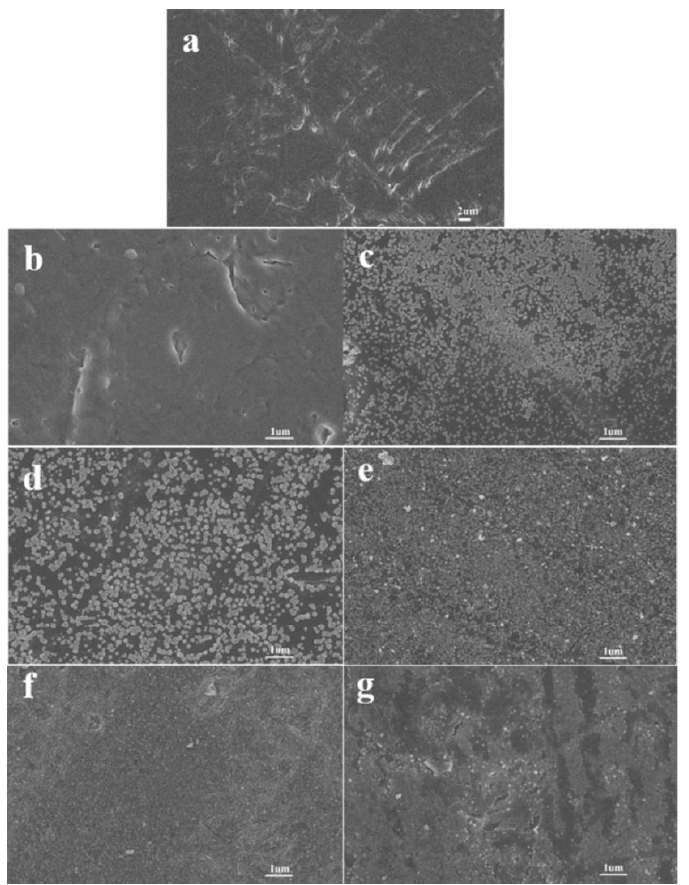
Figure 1. SEM images of the surface of FEP films activated by sodium naphthalene-THF solution with different concentrations and activation times: ( a ) FEP, ( b ) FEP-THF-0.1 M-10 s, ( c ) FEP-THF-0.1 M-30 s, ( d ) FEP-THF-0.2 M-10 s, ( e ) FEP-THF-0.2 M-30 s, ( f ) FEP-THF-0.3 M-10 s, ( g ) FEP-THF-0.3 M-30 s.